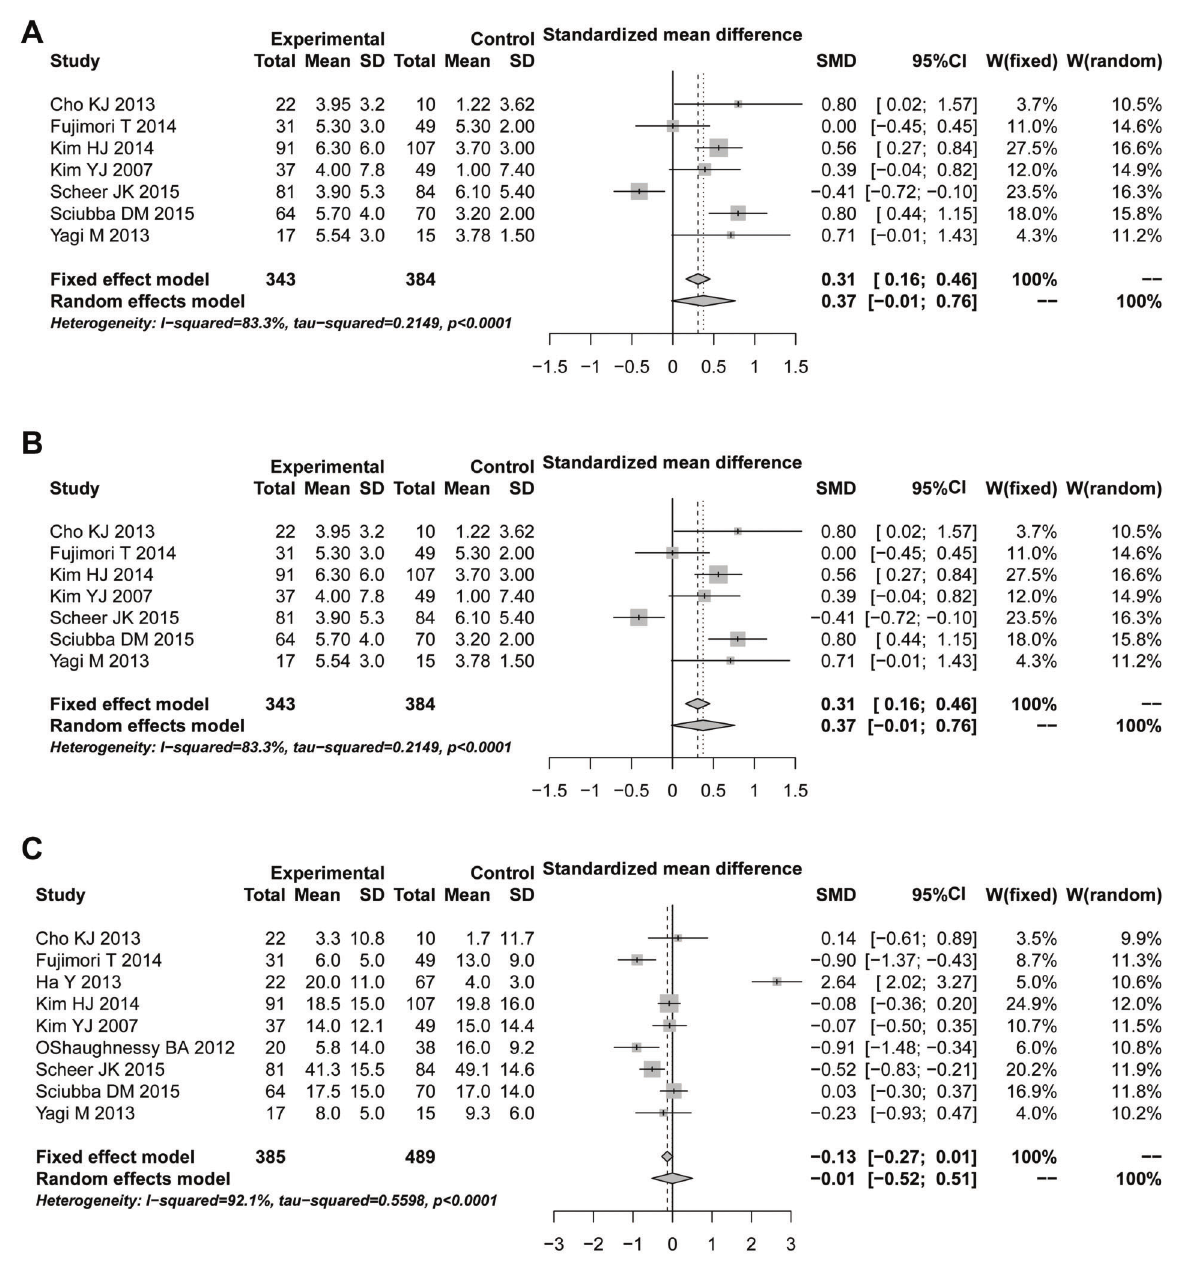
Figure 4. Forest plots for radiographic outcomes based on sagittal vertical axis ( A ), lumbar lordosis ( B ), and thoracic kyphosis ( C ). UT (experimental group): upper thoracic; LT (control group): lower thoracic. See Table 1 for reference numbers of cited